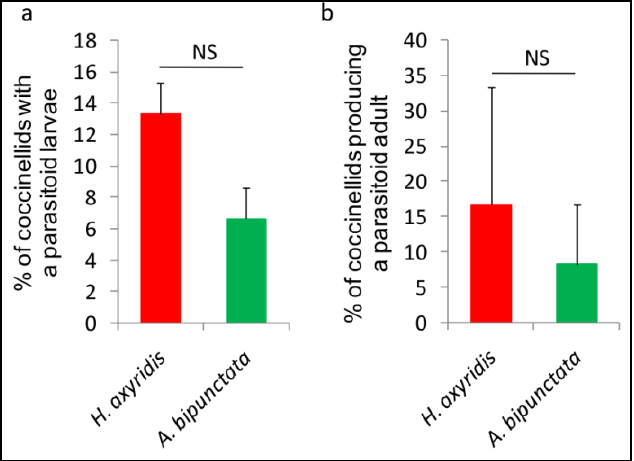
Figure 2. Acceptance ( a ); and suitability ( b ) of H axyridis vs. A. bipunctata by D. coccinellae ( n = 6 for both tests). Percentage (mean ± SE) of lady beetles containing a parasitoid larva ( a ); or producing a parasitoid adult ( b ). See text for